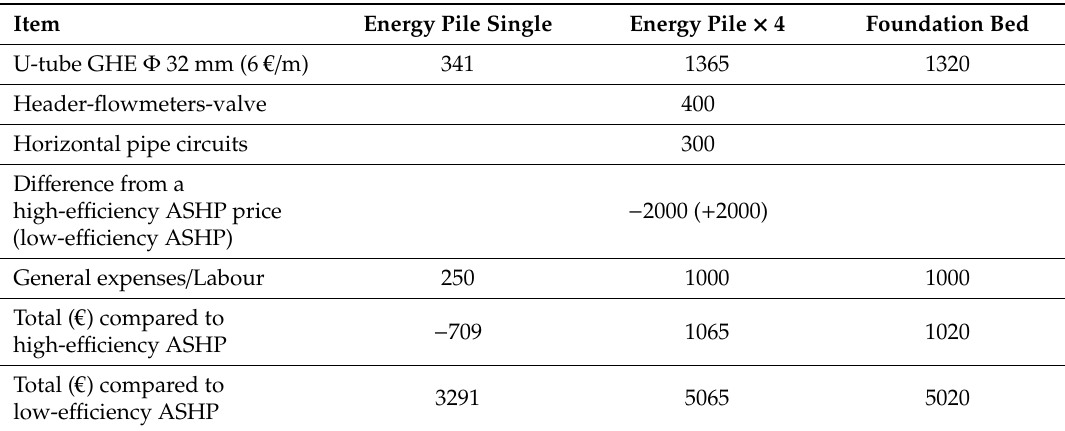
Table 6. Typical extra cost values for the installation of a